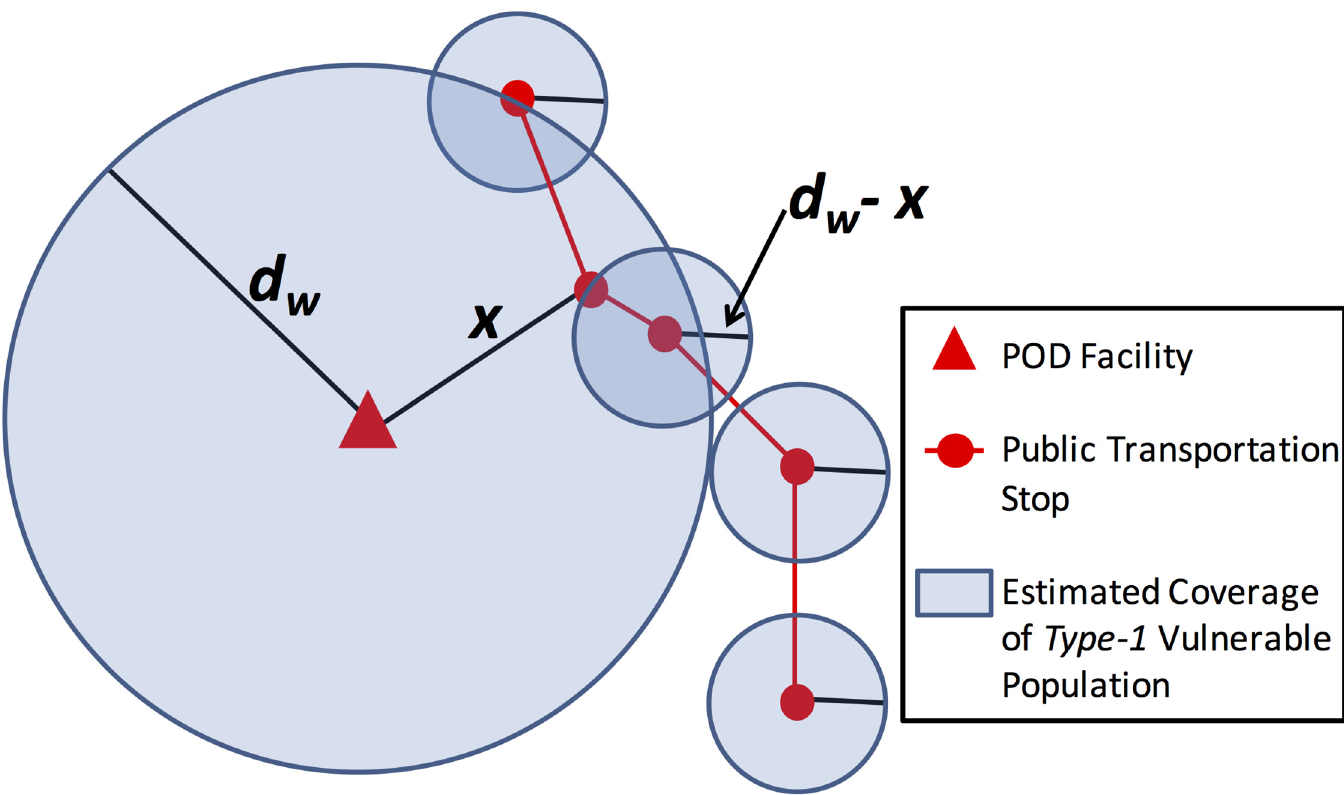
Fig 1. Type-1 Quantification: Coverage area estimation. Estimating the coverage area of POD for Type-1 transportation vulnerable population.